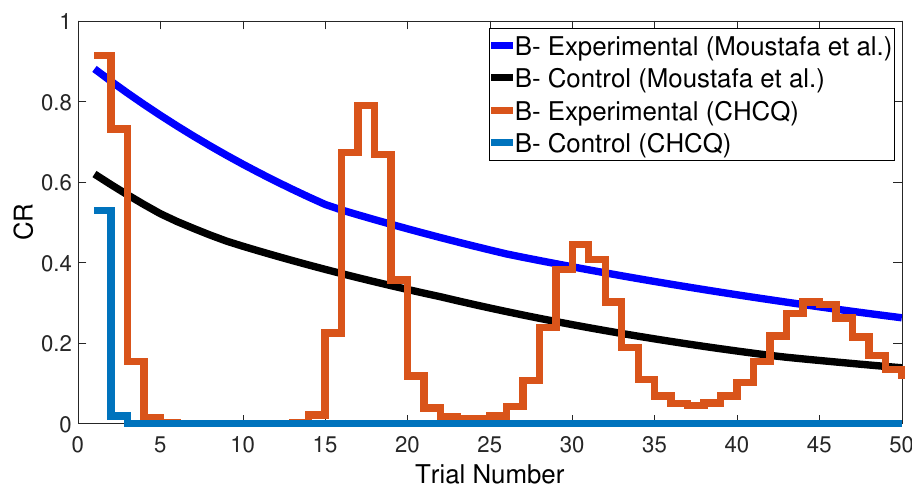
Figure 28. The response of the last phase of sensory preconditioning task for the intact system.